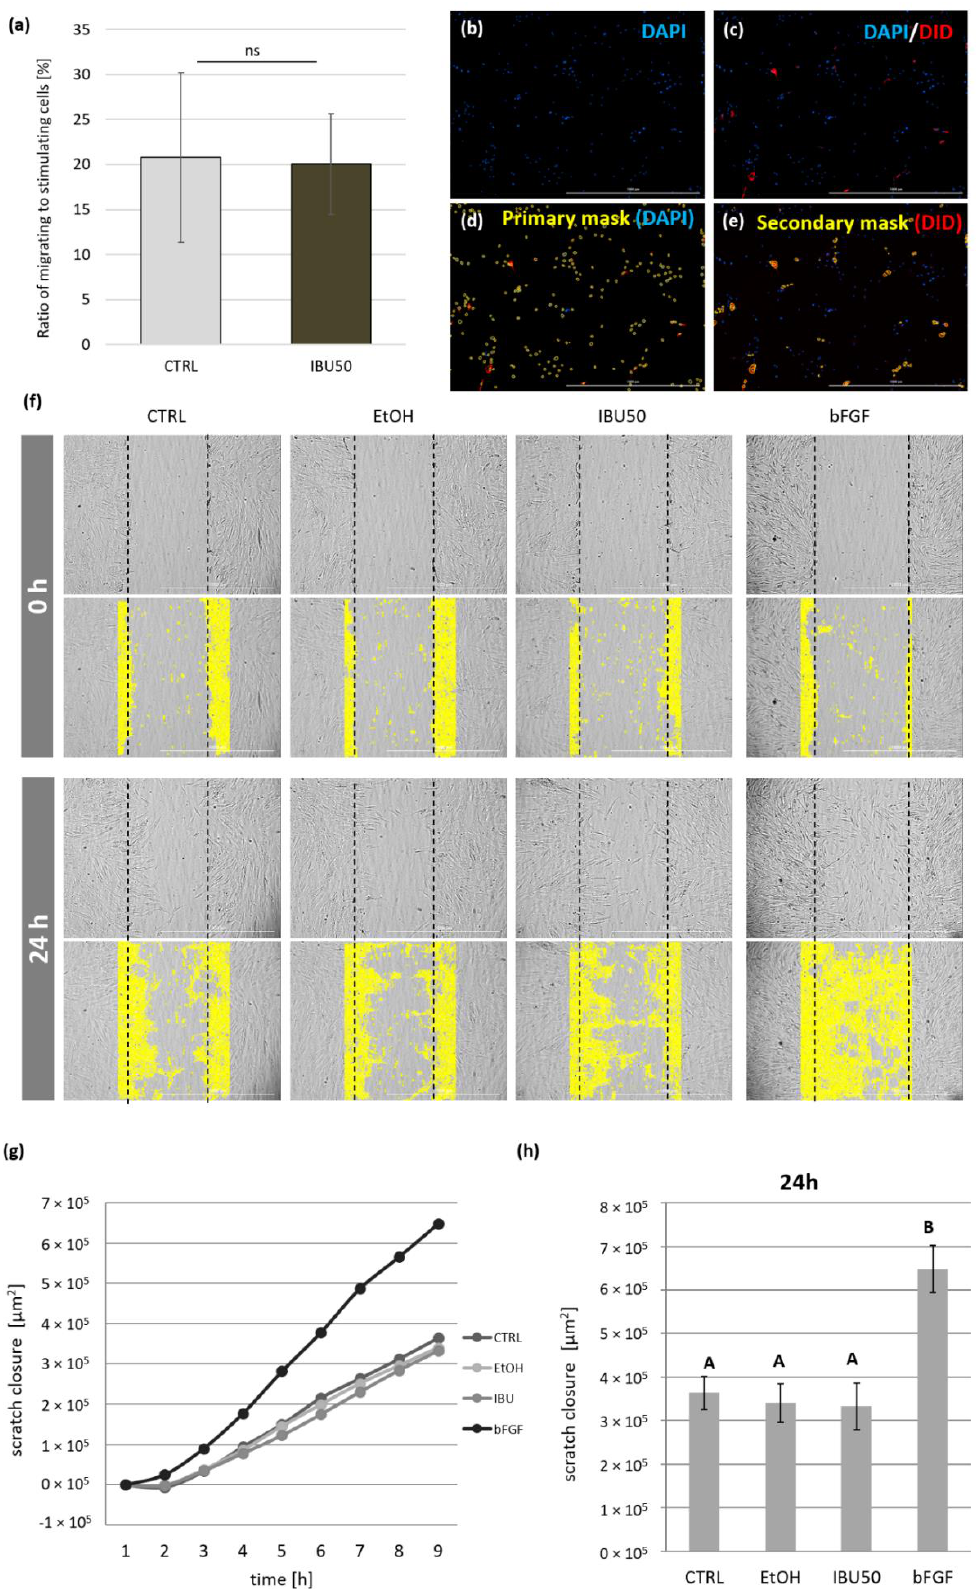
Figure 4. The effect of ibuprofen (50 µ g/mL) on the migration of human BM-MSCs. ( a ) Transwell migration assay. The experiment was performed in duplicates on 6 hBM-MSCs populations.